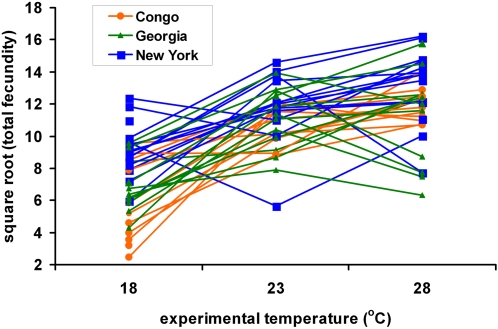
Genotype-by-environment interactions in fecundity of D. melanogaster genotypes at three experimental temperatures.Least squares mean fecundities (Model D, see Materials and Methods) are plotted for D. melanogaster genotypes isolated from Congo, Africa (orange circles), Georgia, USA (green triangles), and New York, USA (blue squares). Plotted data are the square root of the total fecundity over the 48 hour experimental period for flies that were anesthetized with CO2 but otherwise uninjured. The genotype-by-temperature interaction is highly significant, p<0.0001.